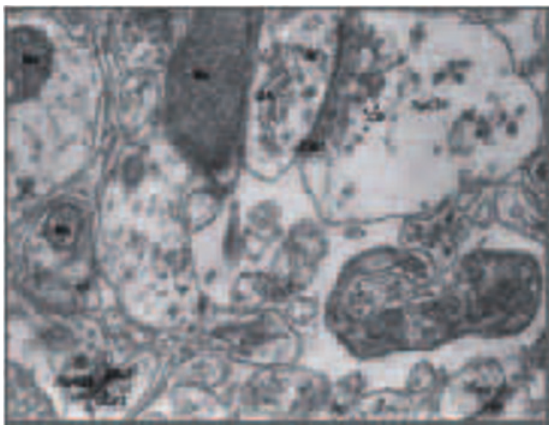
Figure 1. Axon-arrow concave punch synapse layer II of the rabbit brain TCD experimental mild craniocerebral injury. Signs neuropile edema, swelling of pre- and postsynaptic terminals and arrow’s apparatus synapses. Reducing the number, adhesion and erratic distribution of synaptic vesicles (SV - arrow) in the presynaptic terminal. Electron micrograph, increase x 22